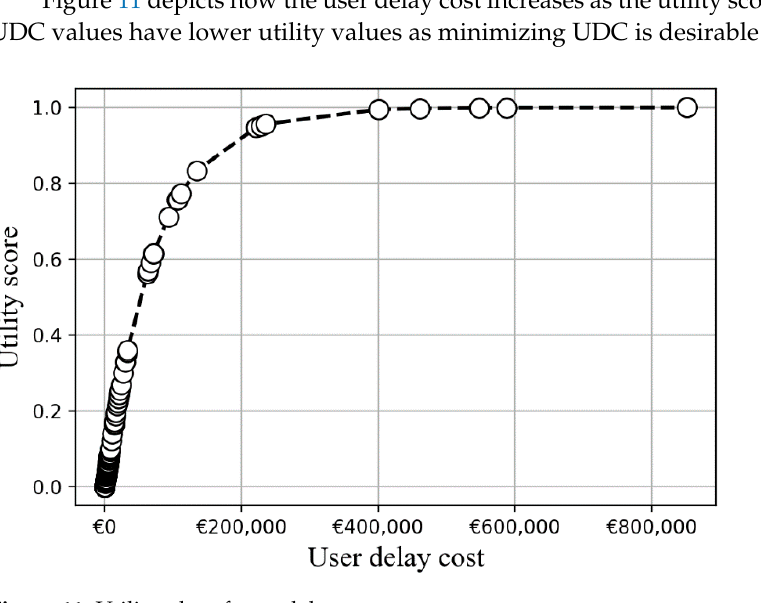
Table 3. Weighting of attributes.